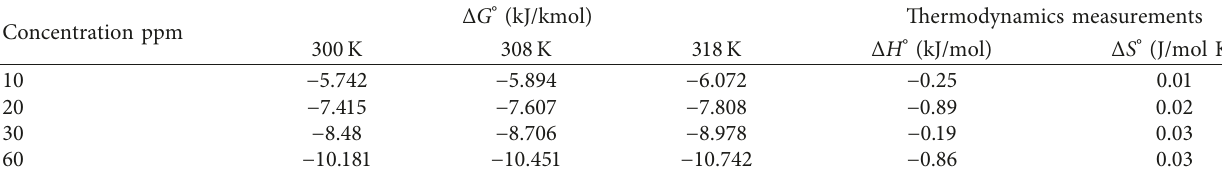
Table 4: Thermodynamic data of the batch adsorption experiment of dieldrin onto nanocomposite. Concentration ppm